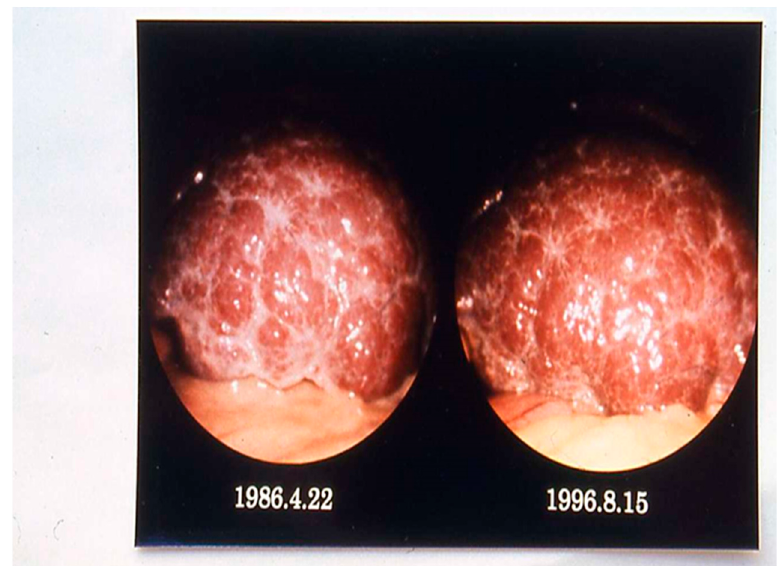
Figure 6. Laparoscopy of a schistosomiasis patient carried out twice with a 10-year intermission. Liver enlargement and less pronounced fibrosis with mild, irregular groove-like septa can be seen in the later investigation (Courtesy, Prof. S. Hayashi).